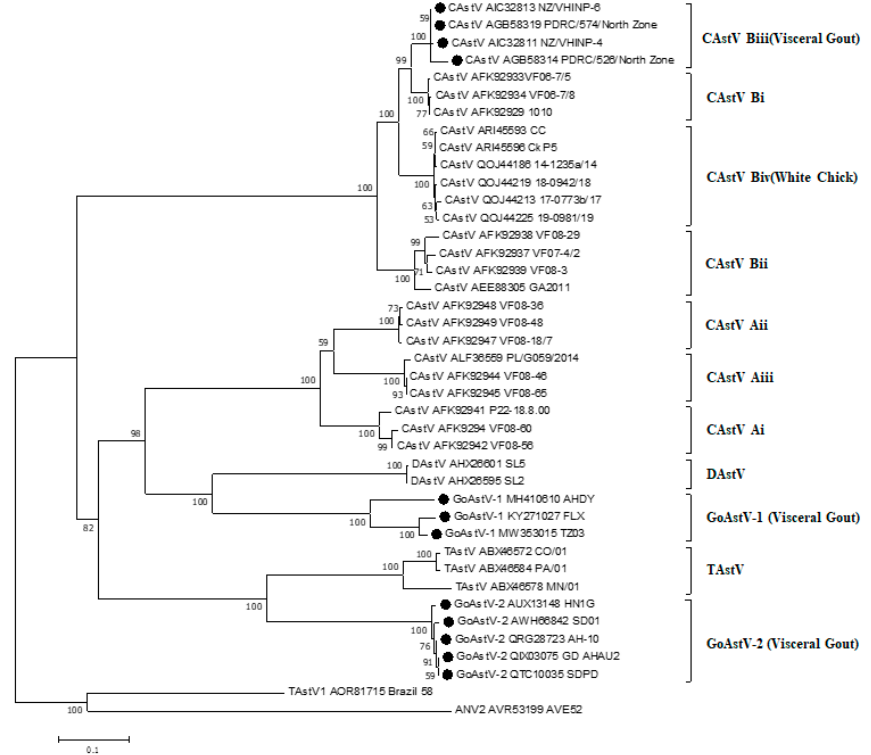
Figure 3. Phylogenetic tree of avian Astrovirus based on complete amino acid sequences of the capsid protein. The tree was constructed using Mega 7.0.14 software (DNASTAR Inc., Madison, WI, USA). using the neighbor-joining method and 1000 bootstrap replicates (bootstrap values are shown on the tree). Avian nephritis virus serotype 2 (ANV-2) was used to root the tree. Strains causing visceral gout were marked with black dots.